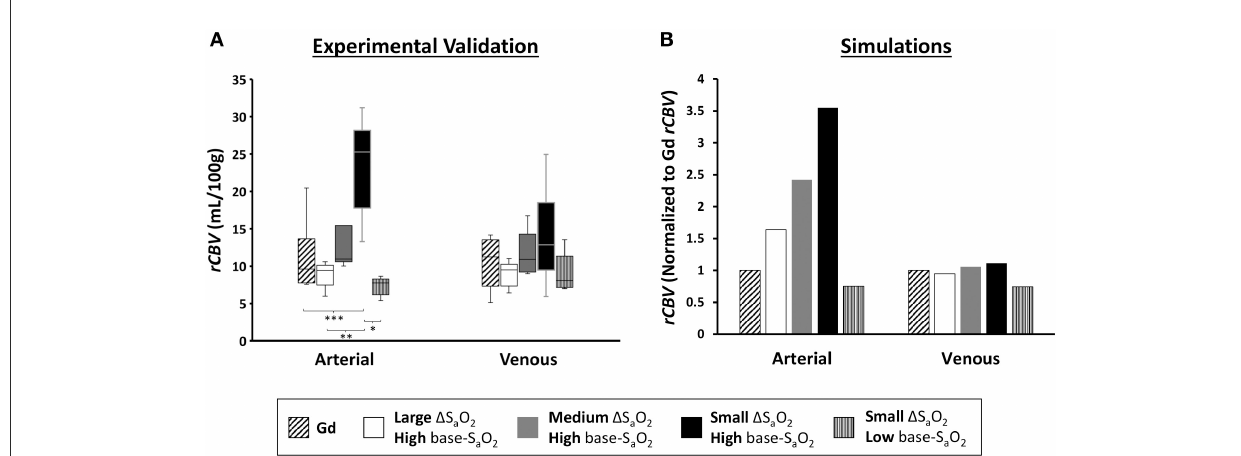
FIGURE6 rCBV Dependency on Arterial vs. Venous Normalization. (A) Validations. Box and whisker plot of calculated rCBV when normalizing tissue to arterial voxel in the MCA vs. venous voxel in the SSS ( n = 6) for Gd and dOHb at varying 1 S a O 2 and Base-S a O 2 . Significant differences are denoted with asterisks. (B) Simulations. Calculated rCBV when normalizing tissue to simulated artery or vein for the same paradigms as in the experiments. Calculated values for all paradigms are further normalized to the rCBV attained with Gd (values above one are an overestimation relative to Gd).